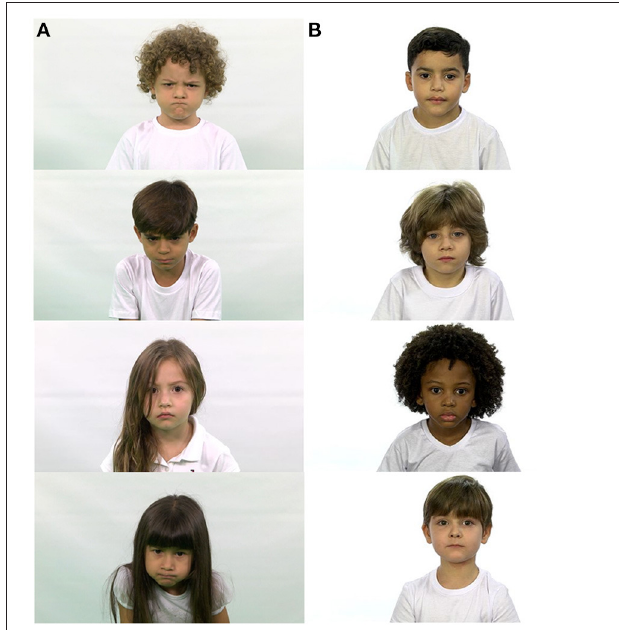
FIGURE 4 | Examples of ChildEFES database images. (A) Anger (B) Neutral.